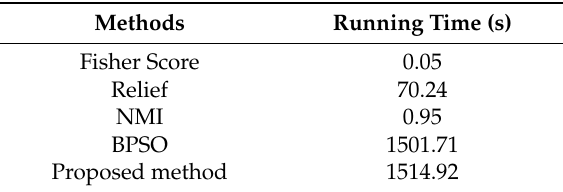
Table 9. Running time